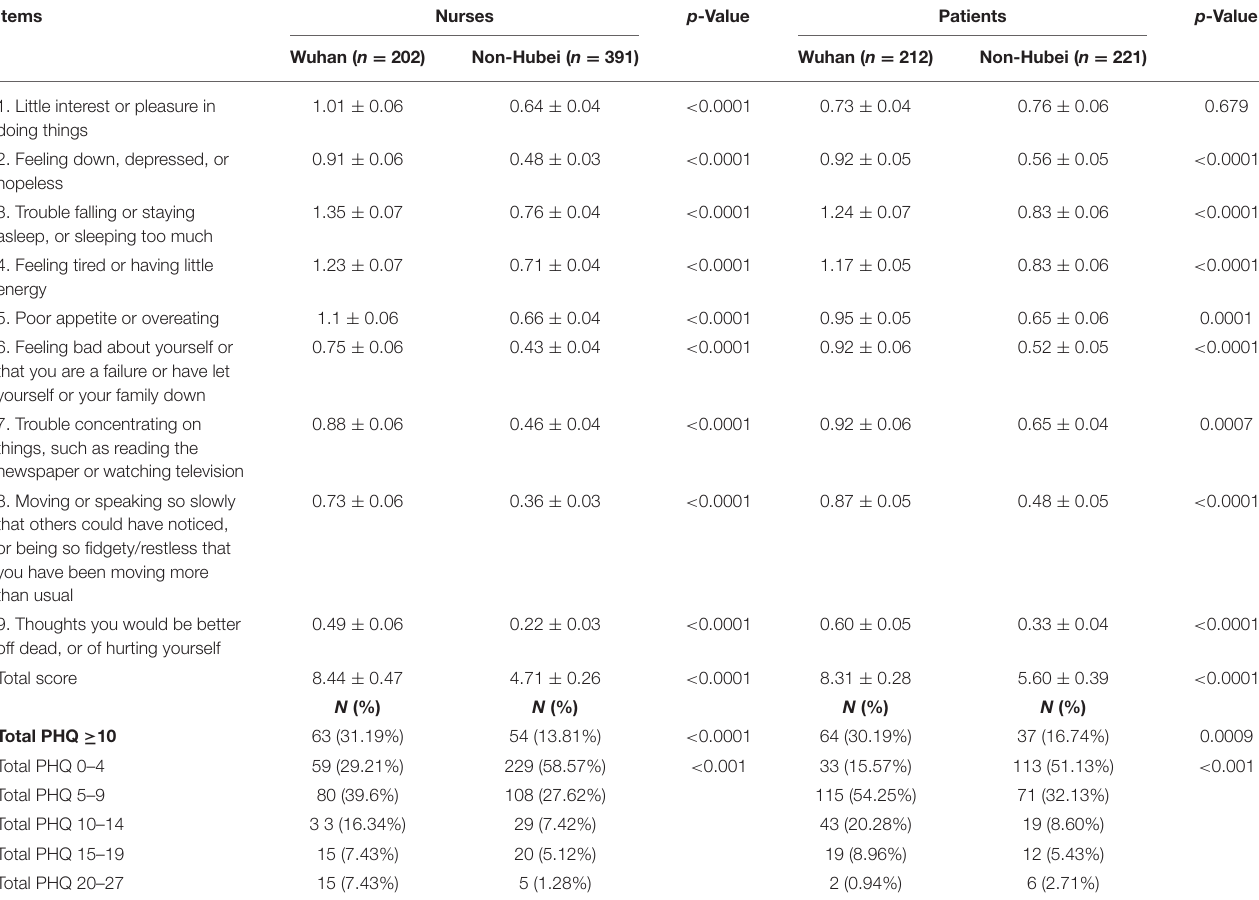
TABLE 3 | Outcomes of PHQ-9 for nurses and patients (Mean ± SE).